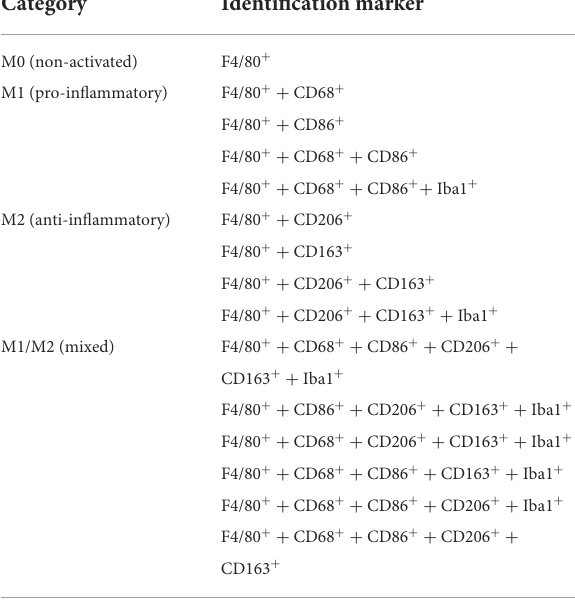
TABLE 1 Categorization of macrophages according to their expressed